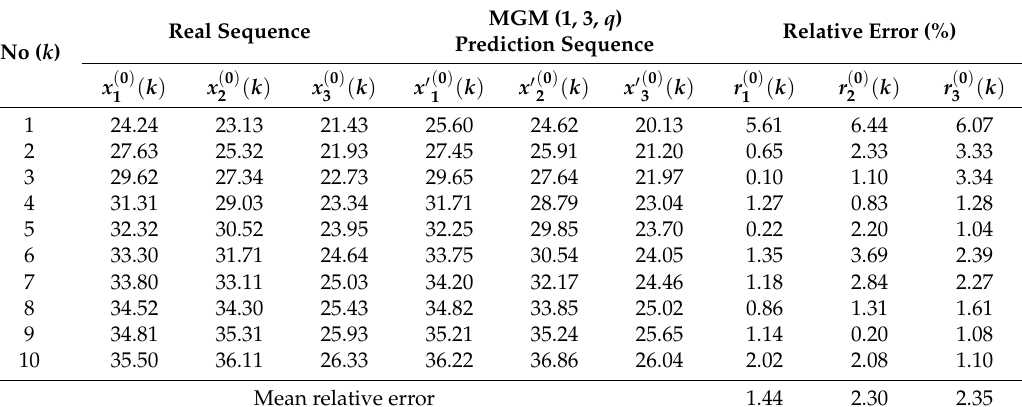
Table 4. Prediction value and error analysis of BP neural network